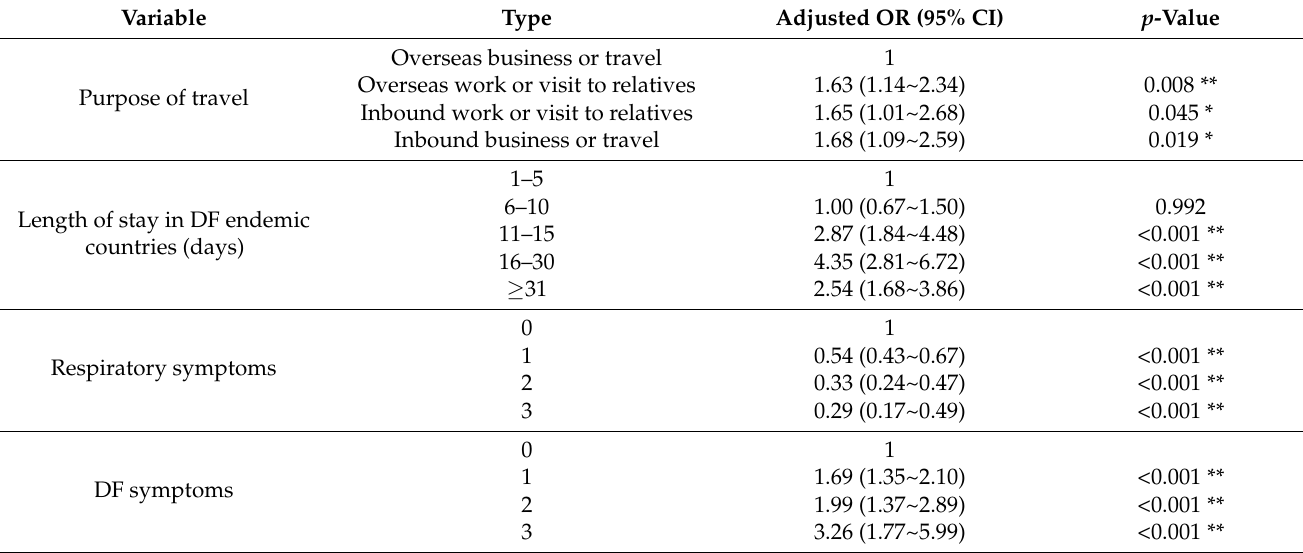
Table 2. Correlation analysis of the positive DF test rates of passengers at international airports from 2018 to 2019 ( n =